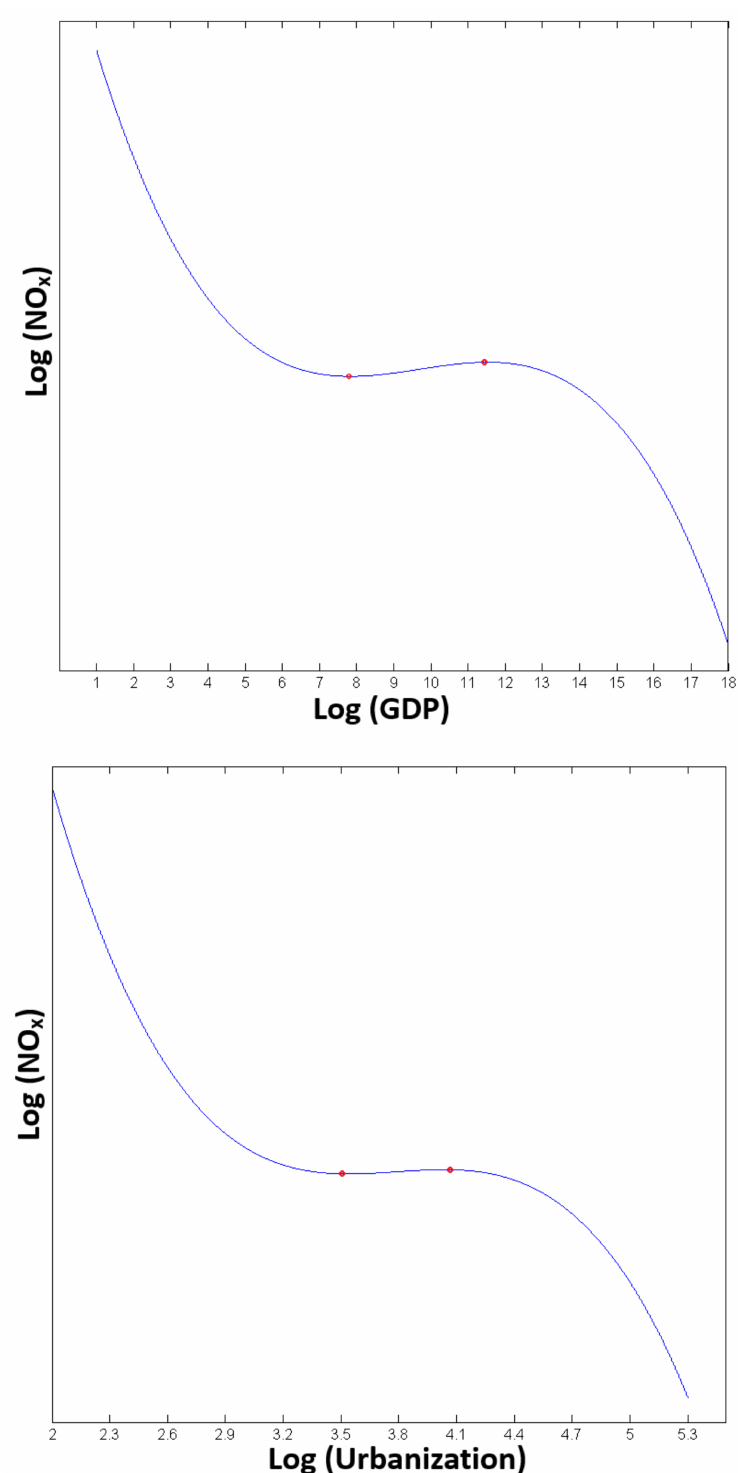
Figure 2. The partial fit of the GDP–NO x , Urbanization–NO x emissions nexuses (logarithm transformed). Note: These two graphs aim to reveal the GDP–NO x and Urbanization–NO x relations, but not to predict NO x emissions levels. Thus, the values on Y -axis are omitted. The turning points (marked with red dots) in the GDP–NO x nexus are 7.8443 (2551 RMB) and 11.5403 (102,775 RMB), whereas in the Urbanization–NO x nexus they are 3.5428 (35%) and 4.0373